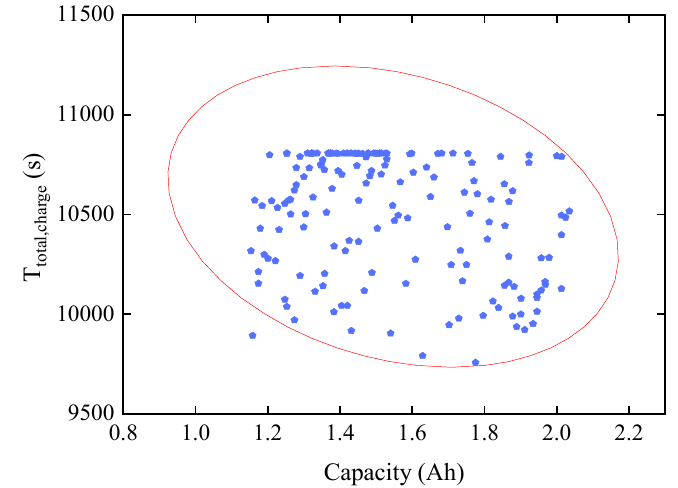
Figure 6. Scatter figure of T total,charge .